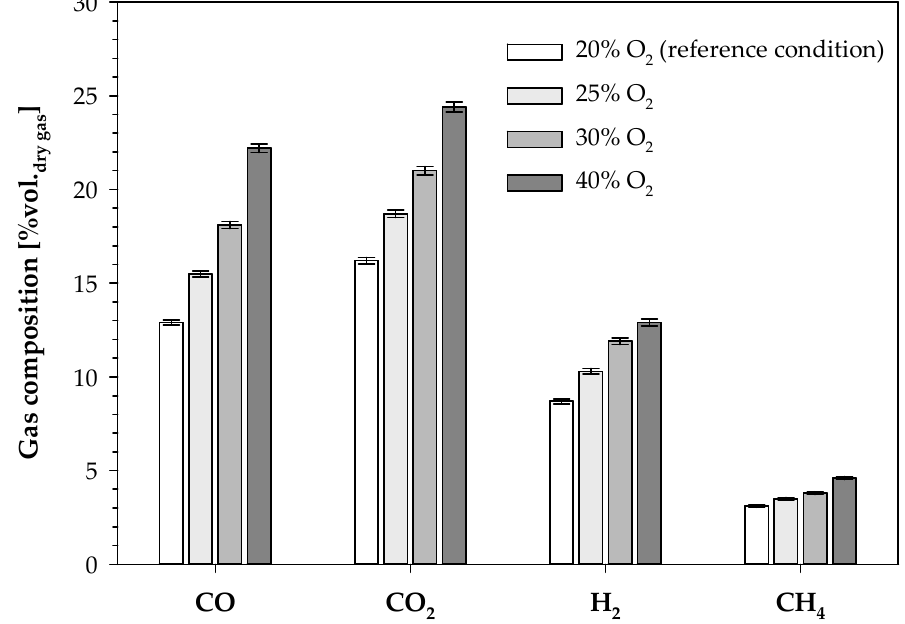
Figure 6. Effect of O 2 concentration ( ϕ ) in the gasification agent, on the producer gas most abundant components concentration (N 2 concentration excluded) during air gasification of RFB from eucalyptus (SBR = 0.0 kg steam ∙ kg − 1biomass —Tables 3 and 4).